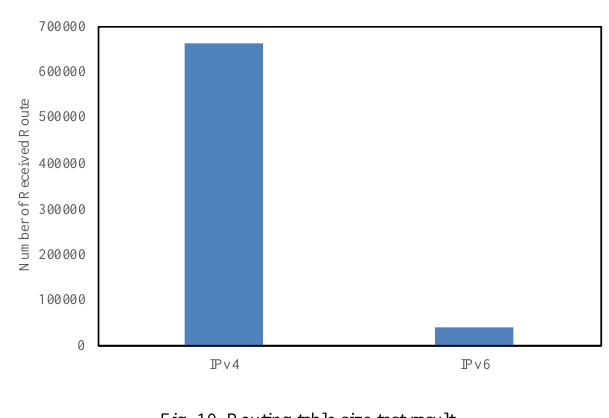
Fig. 19. Routing table size test result